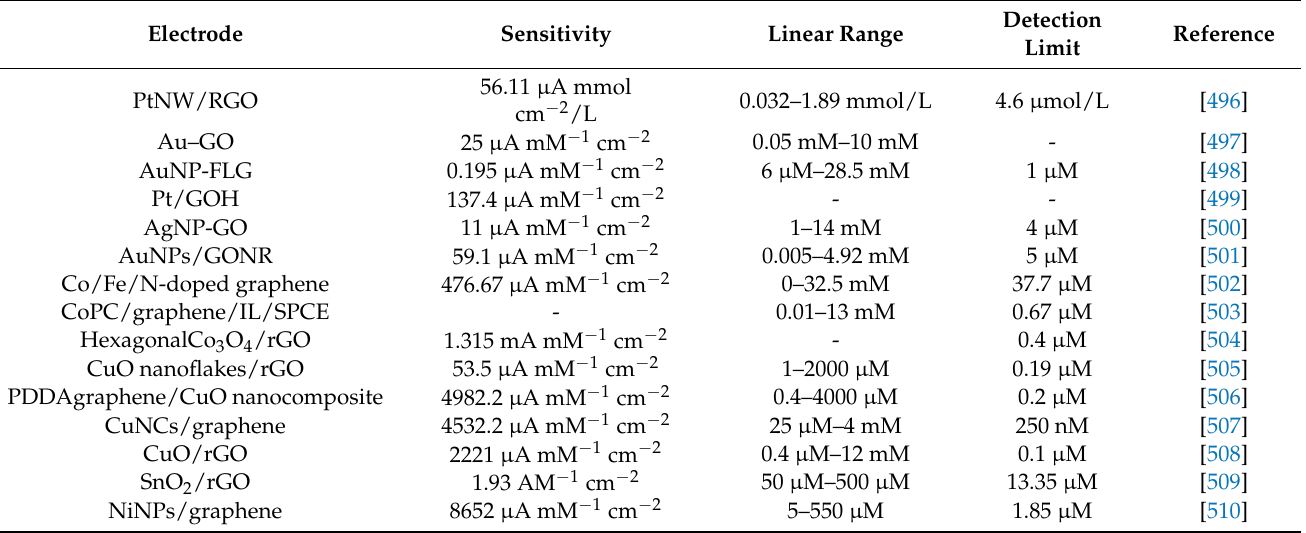
Table 5. Graphene-based glucose